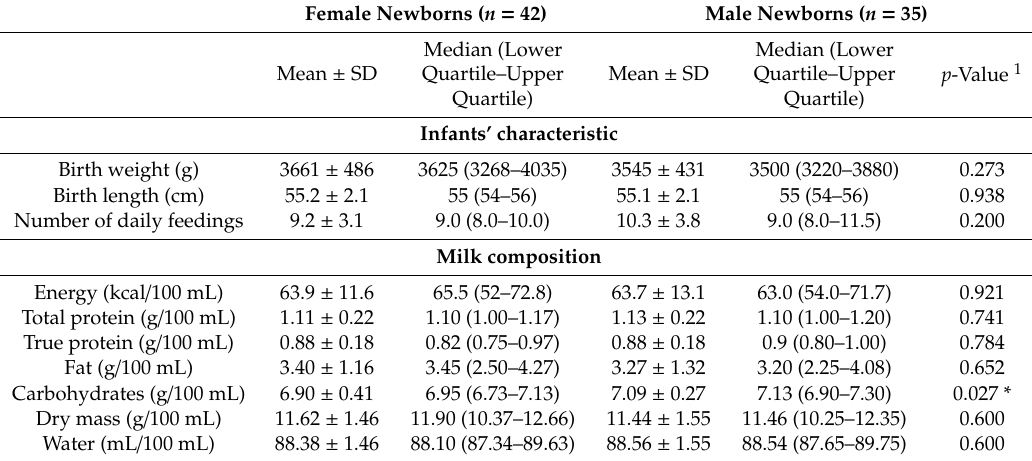
Table 3. The comparison of anthropometric data, feeding frequency and human milk composition in female and male